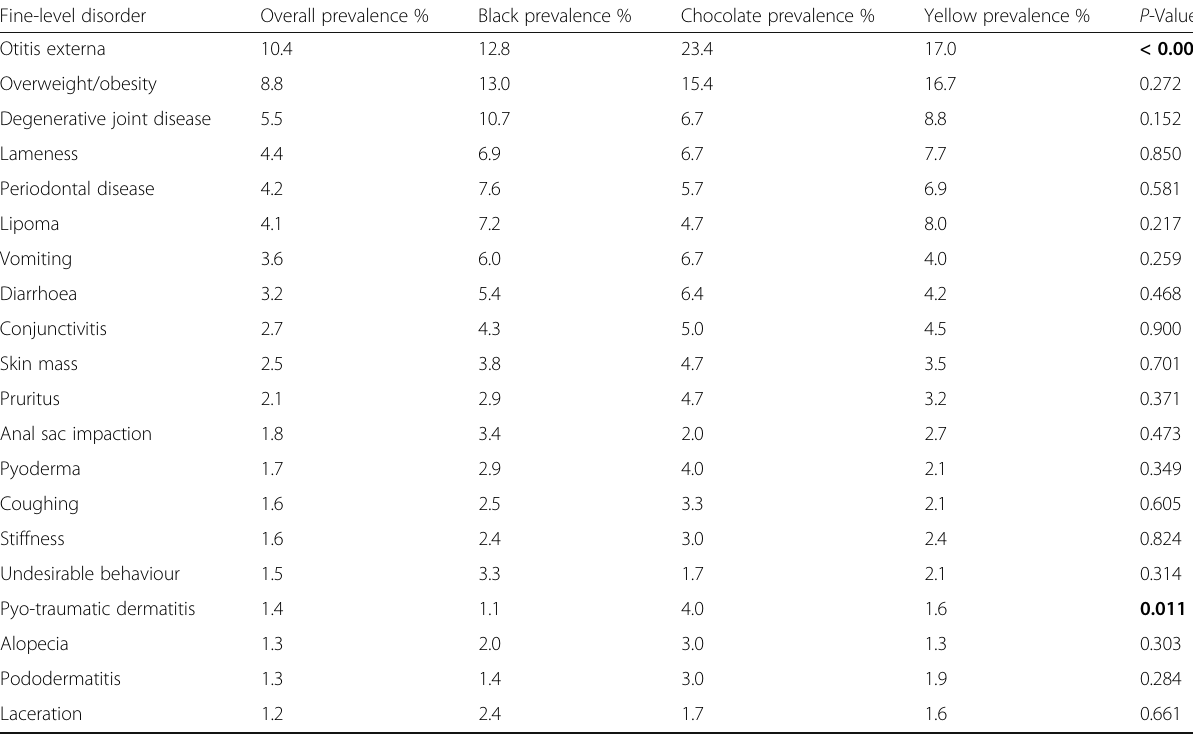
The P -value reflects prevalence comparison between the three colours. ( n =2074) P -values in bold are statistically